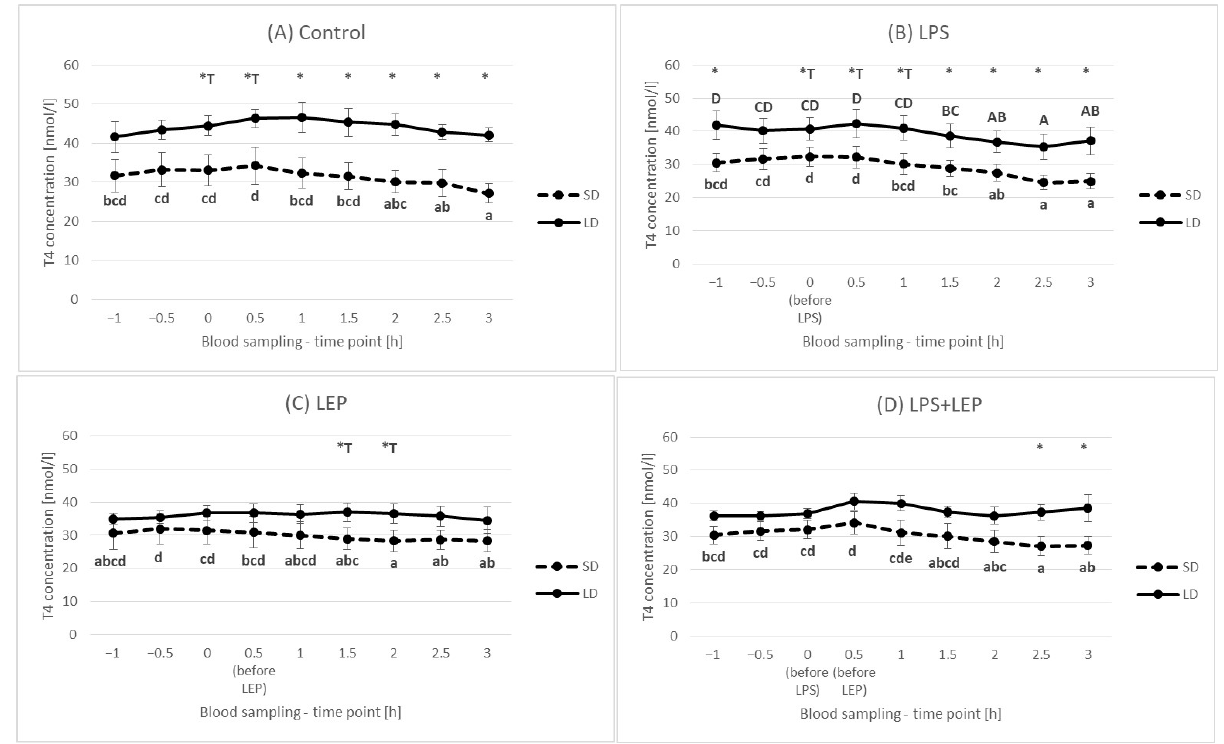
Figure 11. Plasma thyroxine (T4) concentration for each experimental group separately (Control ( A ), LPS ( B ), LEP ( C ) and LPS + LEP ( D )) at each examined time point and season; *—indicates the statistically significant difference between the short-day (SD) and long-day (LD) photoperiods at each time point according to Student’s t -test ( p ≤ 0.05) ( n = 6); *T—indicates the tendency in a difference between photoperiods at each time point according to Student’s t -test (0.1 > p > 0.05); a–d and A–D—indicate the statistically significant difference between time points for the SD and LD seasons, respectively, according to a repeated measured analysis of variance (ANOVA) followed by Fisher’s post-hoc test ( p ≤ 0.05) ( n = 6). Groups: control—saline injection, LPS—lipopolysaccharide injection at a dose of 400 ng/kg of body mass after a 0 h time point, LEP—leptin injected at a dose of 20 μ g/kg of body mass at a 0.5 h time point, LPS + LEP—LPS and LEP injections at the same doses and time points as those in the LPS and LEP